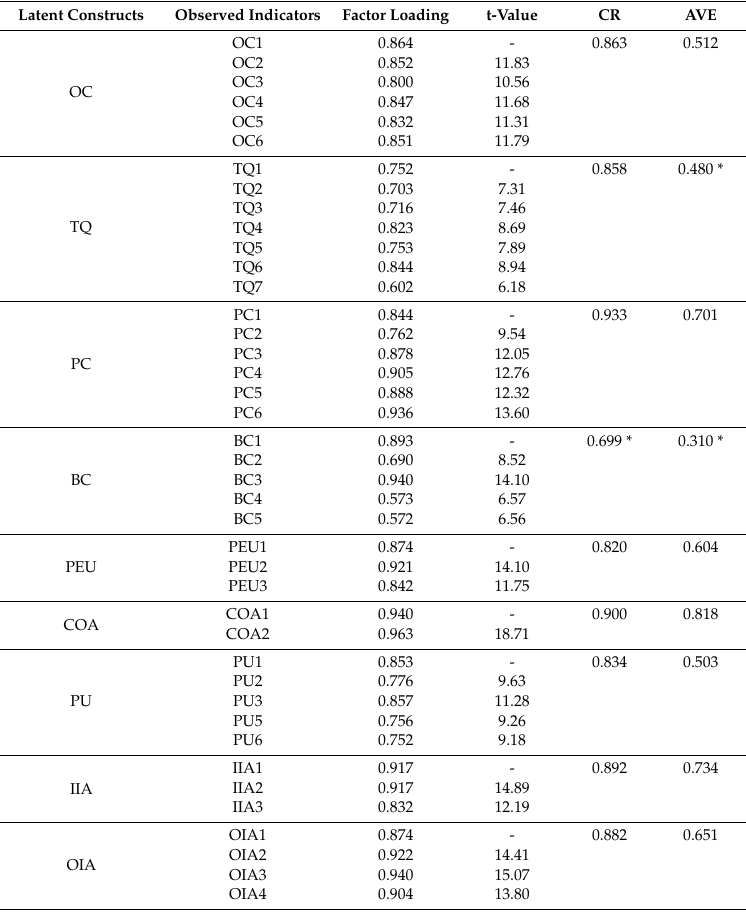
Table 3. Results of the confirmatory factor analysis